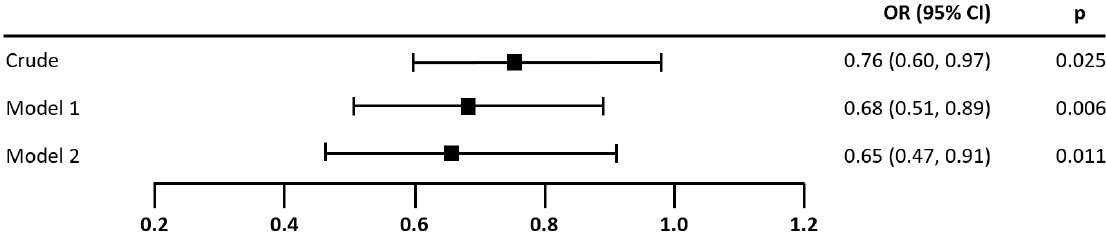
Figure 4. Association of MEDAS score with the presence of atrial fibrillation. Note. N = 104. Odds ratios (OR) for the presence of atrial fibrillation per one point increase in MEDAS. Model 1 was adjusted for income, resting heart rate, log MET, energy intake, and diet change in the past year. Model 2 was additionally adjusted for log NT-proBNP. The odds ratio for log NT-proBNP in Model 2 was significant: OR (95% CI) = 19.43 (7.41–183.27), p < 0.001. Wellness of fit, correct predictions, and overall model-fit statistics—Crude: Nagelkerke’s R 2 = 0.067, 61.54%, Chi 2 = 5.36, p = 0.021; Model 1: Nagelkerke’s R 2 = 0.204, 64.42%, Chi 2 = 17.25, p = 0.016; Model 2: Nagelkerke’s R 2 = 0.491, 79.81%, Chi 2 = 47.82, p <